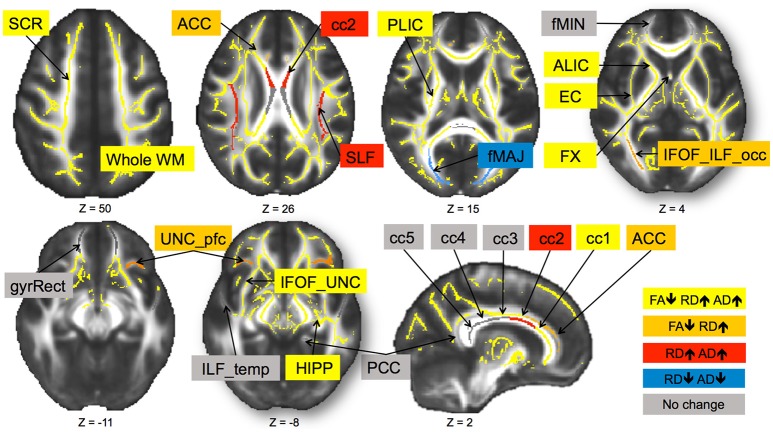
Change in diffusivity measures over 6-months in healthy older adults 60–79 years old. Different patterns of overlap of change in diffusivity parameters are represented by different colors. Superior corona radiata (SCR), superior longitudinal fasciculus (SLF), anterior and posterior limb of the internal capsule (ALIC, PLIC), external capsule (EC), fornix (FX), five regions of the corpus callosum (cc1–5), forceps major (fMAJ), forceps minor (fMIN), anterior and posterior cingulum (ACC, PCC), WM containing occipital portion of inferior longitudinal fasciculi and inferior frontal-occipital fasciculi (IFOF_ILF_occ), WM of the straight gyrus (gyrRect), parahippocampal WM (HIPP), ventral prefrontal part of uncinate fasciculus (UNC_pfc), WM containing uncinate and the inferior frontal-occipital fasciculi (IFOF_UNC), and WM of the temporal pole related to inferior longitudinal fasciculus (ILF_temp). Regions are overlaid on the FMRIB58_FA template.